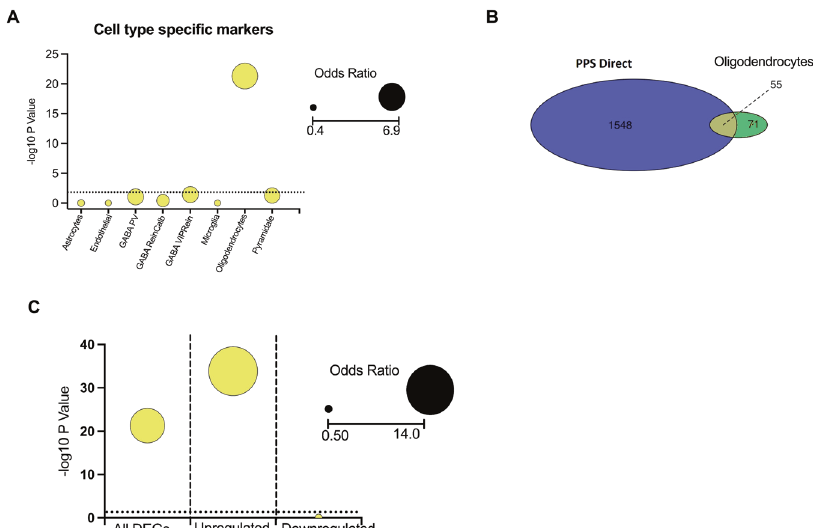
Fig. 3 Cell-type enrichment analysis of DEGs between CON vs PPS animals directly following a social test (Direct group). A Cell-type- speci fi c markers were compiled from a cortical cell-type-speci fi c list and compared for enrichment within our DEGs. We demonstrate enrichment of oligodendrocyte-speci fi c markers. The dotted line indicates the P value signi fi cance line, and the colour and size of the points demonstrate the odds ratio. B Venn diagram demonstrating the overlap between DEGs and oligodendrocyte-speci fi c markers. C When DEGs were split into upregulated and downregulated genes, we see this signal comes solely from upregulated genes. DEGs differentially expressed genes, PPS prepubertal stress.